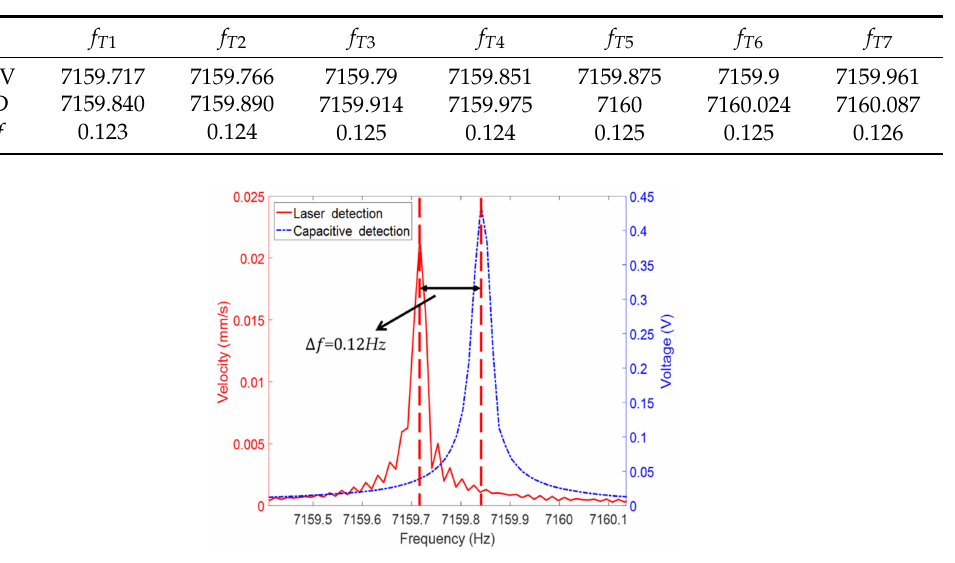
Figure 7. The results of frequency sweeping detected by laser Doppler vibrometer (LDV) and capacitive detection (CD): ( a ) The vibration velocity detected by LDV; ( b ) The vibration signal detected by CD; ( c ) Fast Fourier transform (FFT) results of laser Doppler detection; and, ( d ) FFT results of CD. Table 1. The resonant frequency measured by laser Doppler vibrometer (LDV) and capacitive detection (CD).